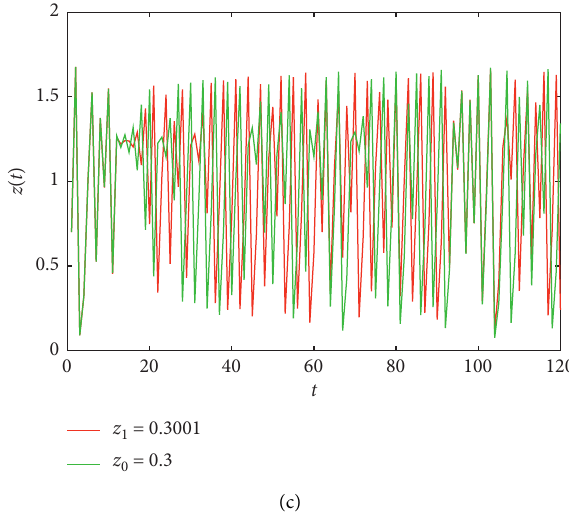
Figure 13: Sensitive dependence on initial conditions: (a) two orbits of x ( t ) with initial values x with initial values y